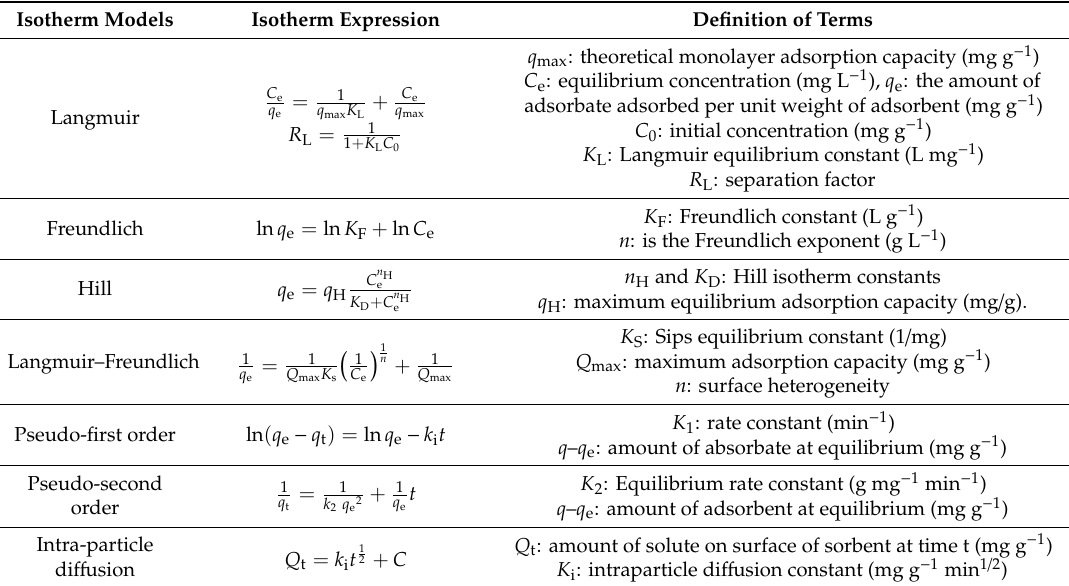
Table 1. Adsorption isotherms and kinetics models